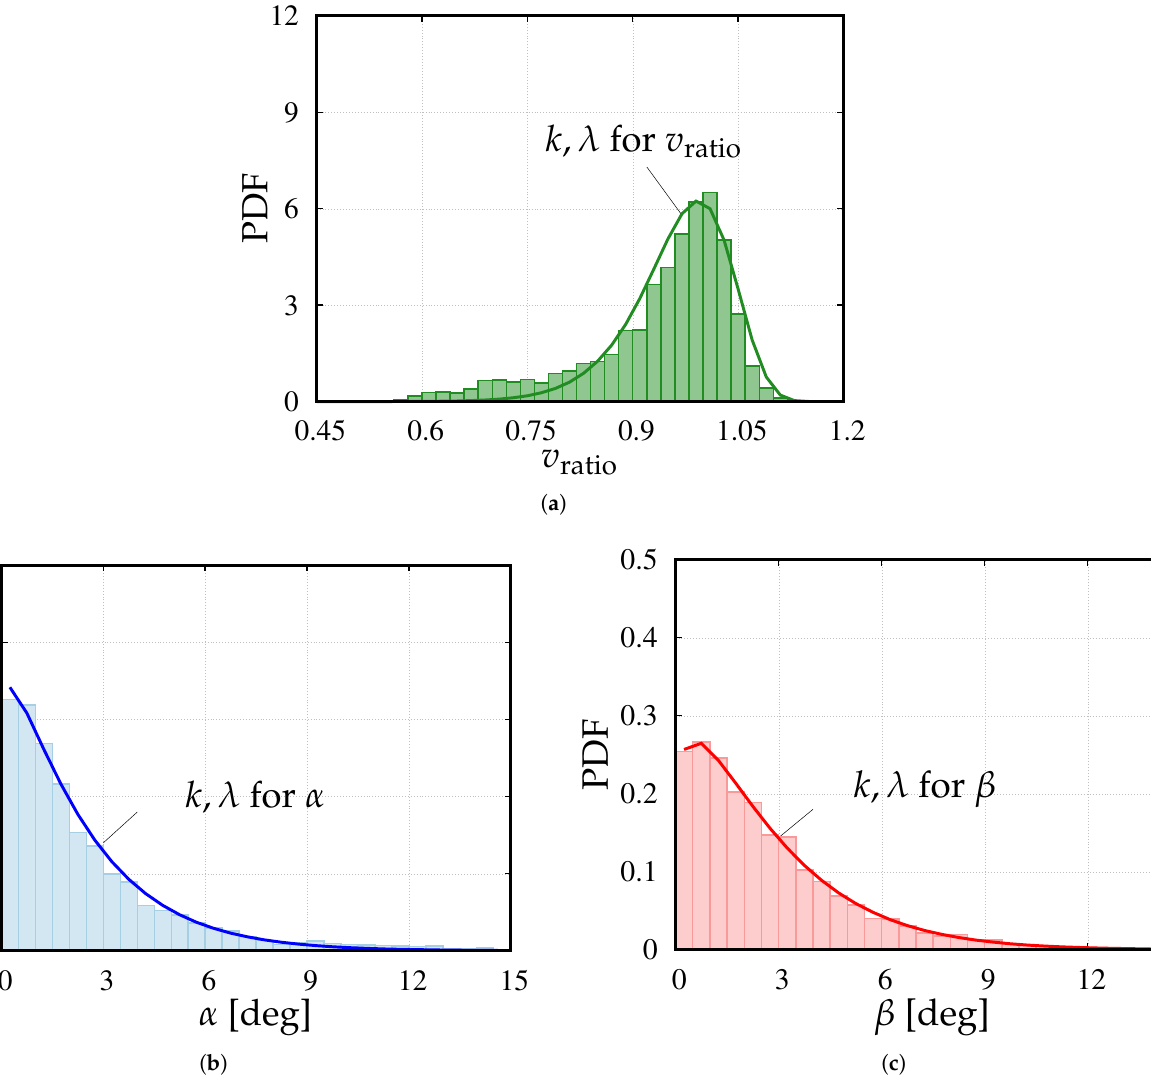
Figure 2. PDF of ( a ) the reflection angle α ; ( b ) the spreading angle β and ( c ) the velocity ratio v ratio . The results correspond to fragments obtained by 64 breakage events of equal impact conditions but with different relative orientations of the agglomerate with respect to the wall. The solid line is fitted to the data by the Weibull distribution given by Equation